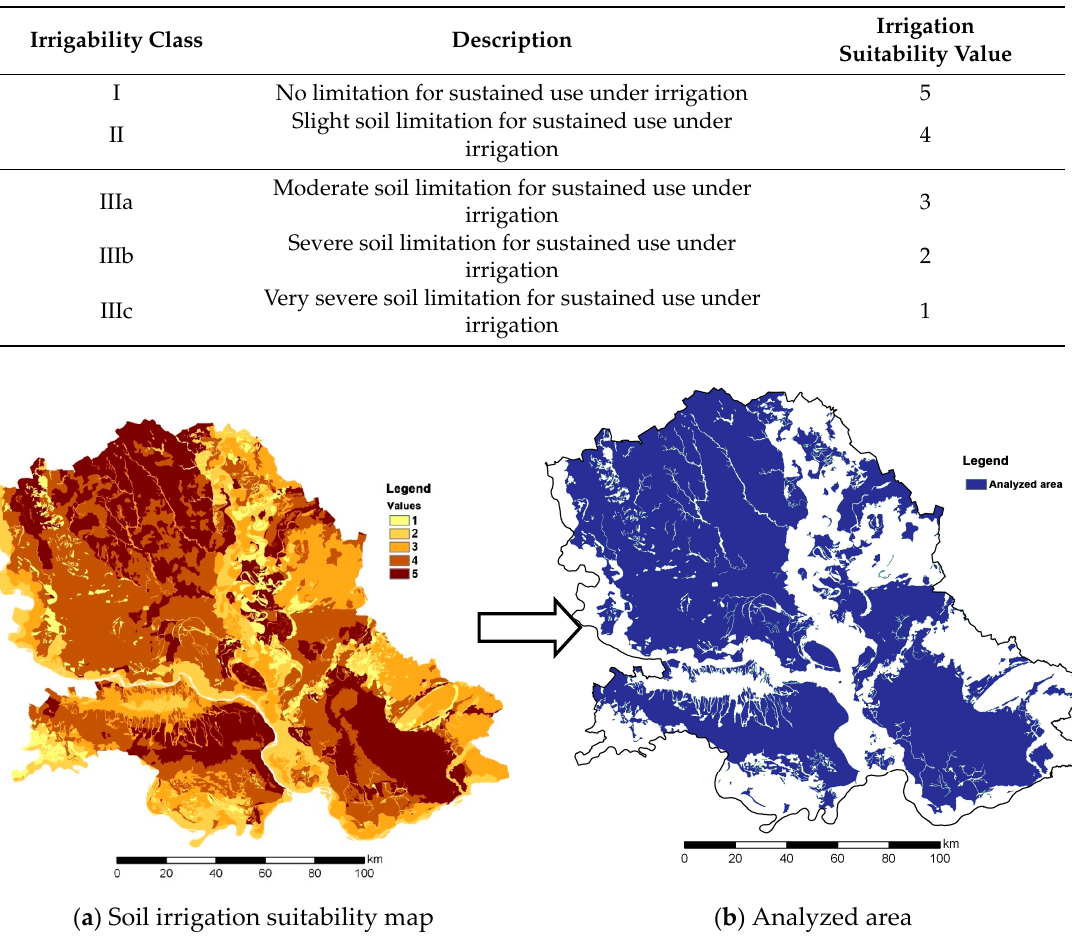
Table 2. Irrigation suitability soil classification [21].